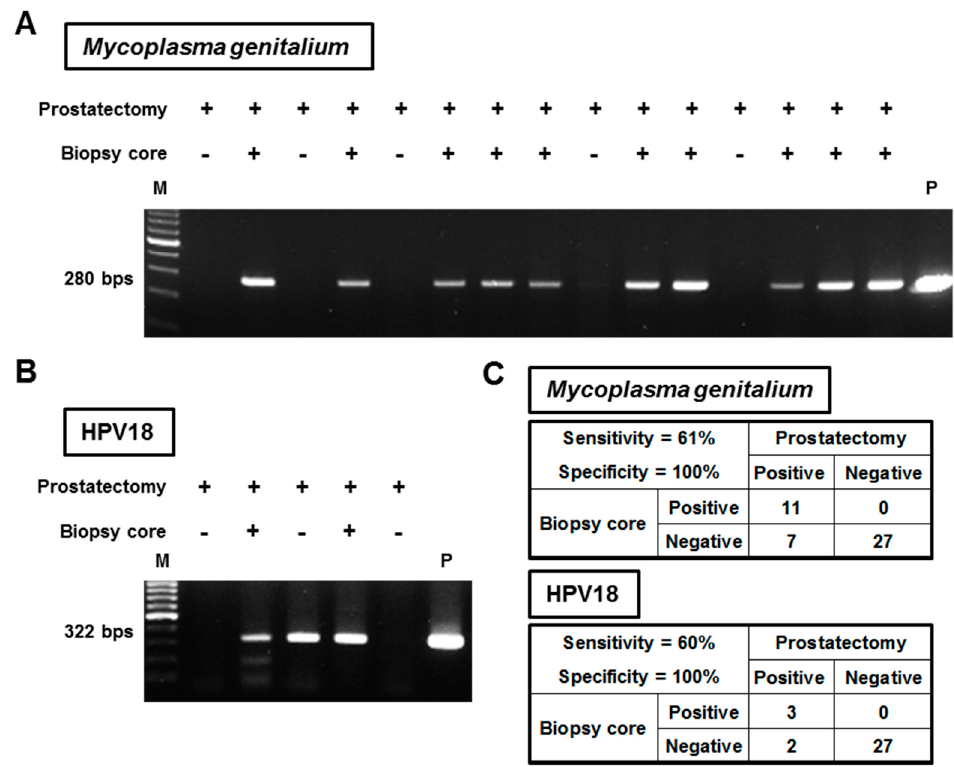
Figure 4. Detection feasibility of Mycoplasma genitalium and HPV18 from prostate needle biopsy specimens. ( A ) DNA isolated from prostate needle biopsy specimens was amplified using